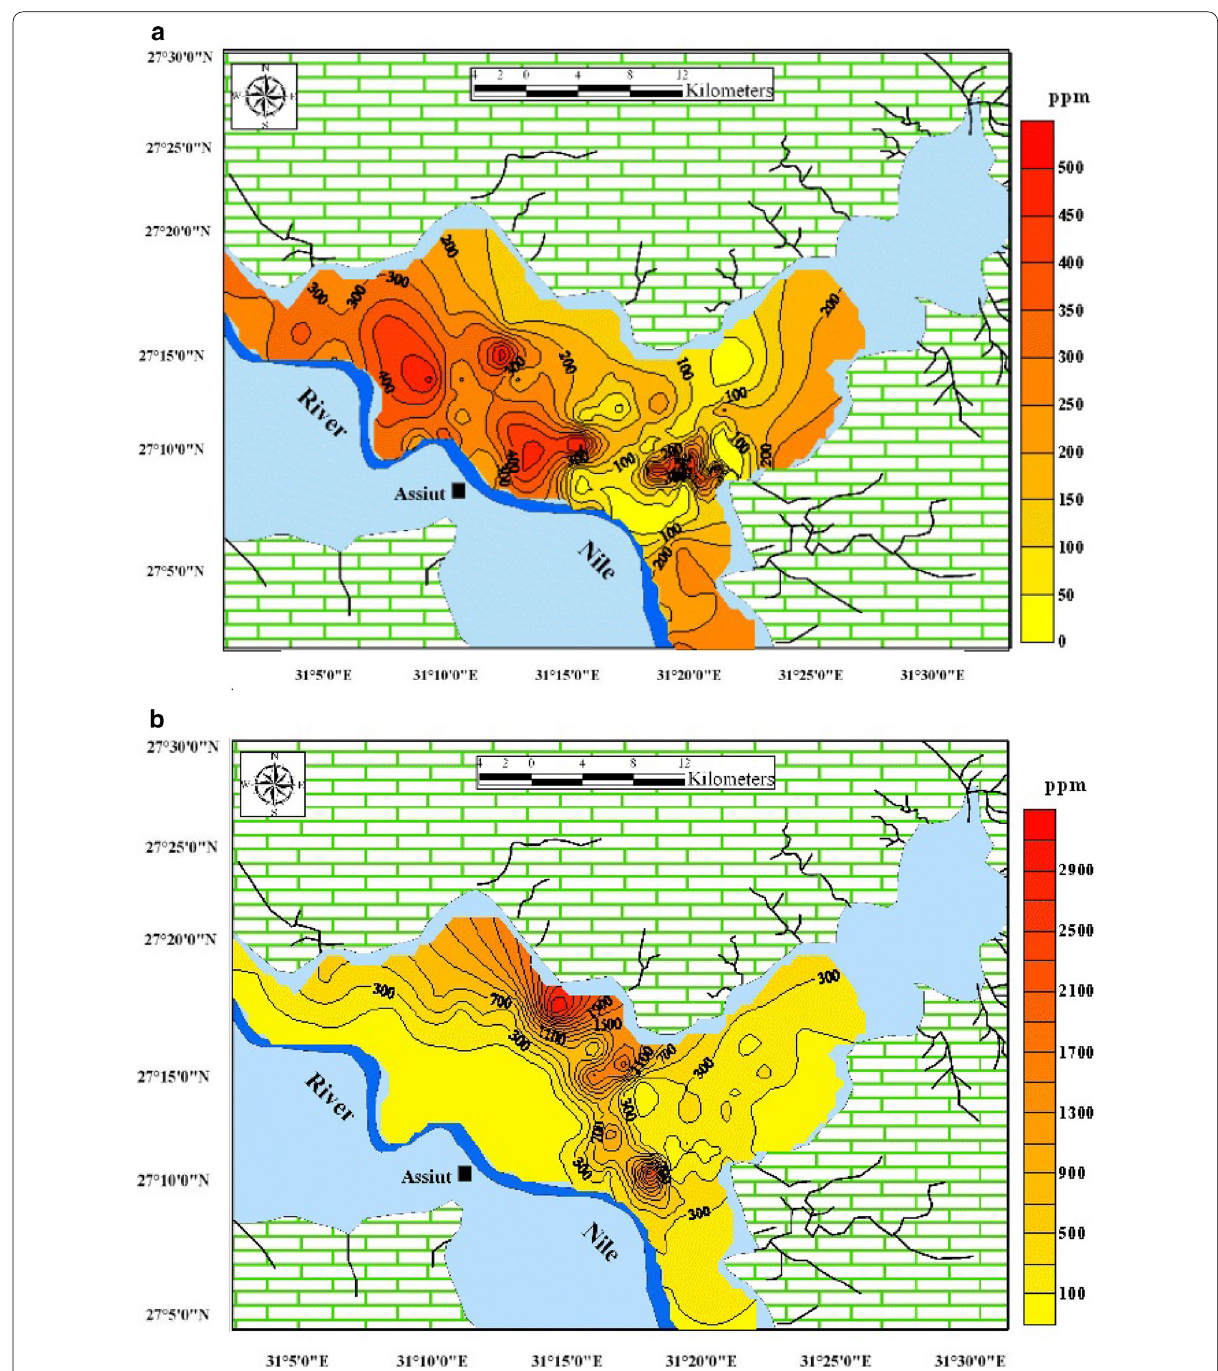
Fig. 7 Spatial distribution of minor ions in studied groundwater samples: a bicarbonate, b sulfate, and c chloride